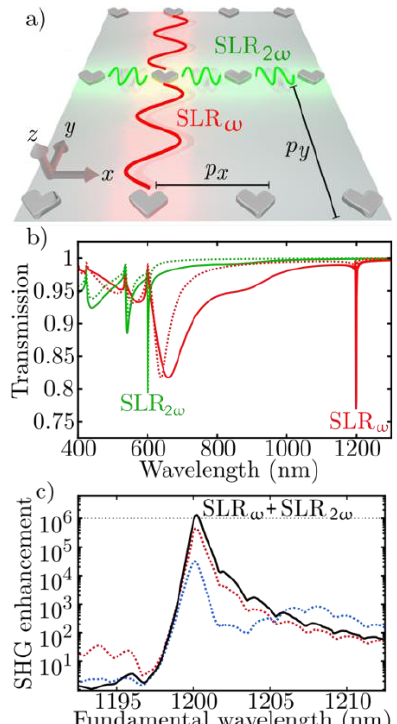
Fig. 2. a) Multiply-resonant metasurface. b) Calculated transmission spectra using the NDDA (dotted lines) and the FDTD (solid lines). Red (green) curves correspond to x - polarized ( y -polarized) incident light. c) Predicted SHG intensity enhancement for a particle at the center of the metasurface. Over million-fold SHG intensity enhancement occurs for the doubly- resonant metasurface (black solid